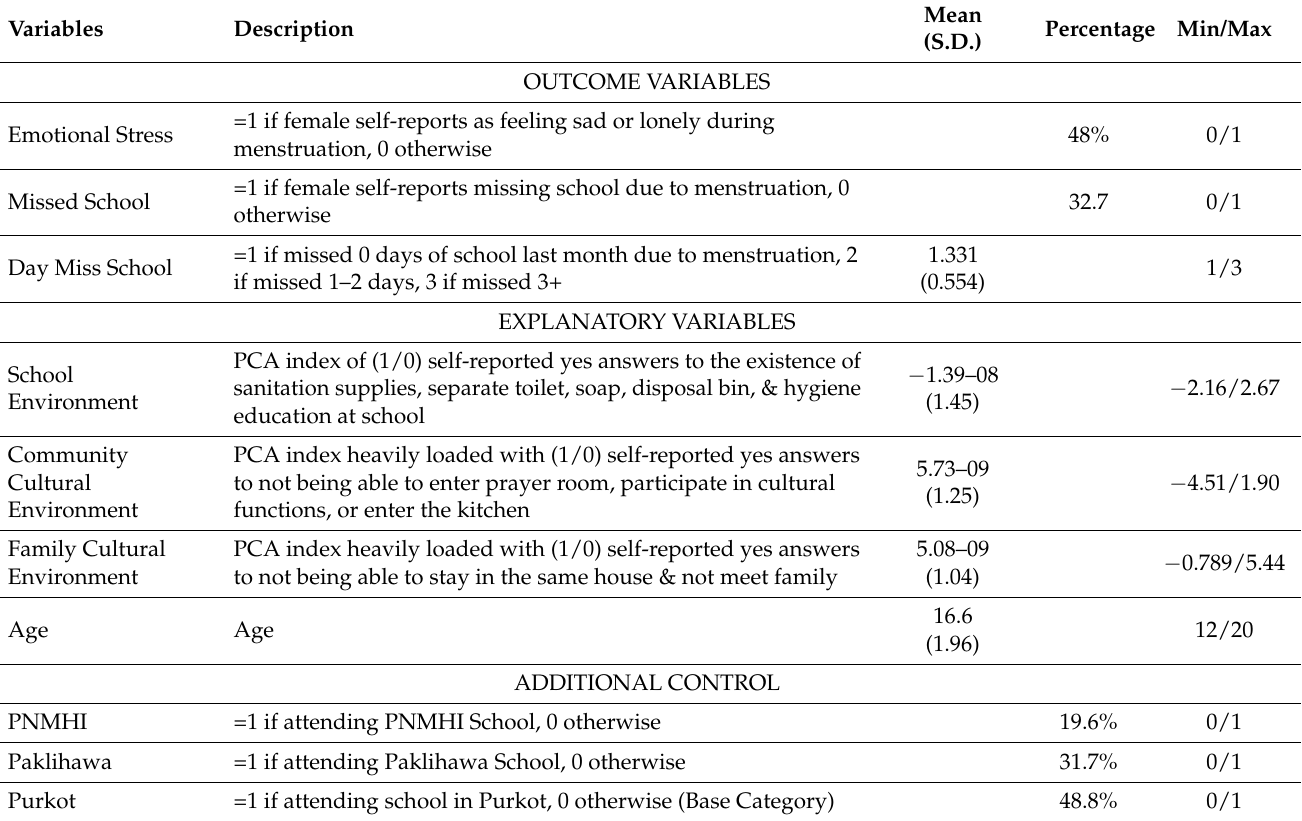
Table 1. Descriptive statistics of